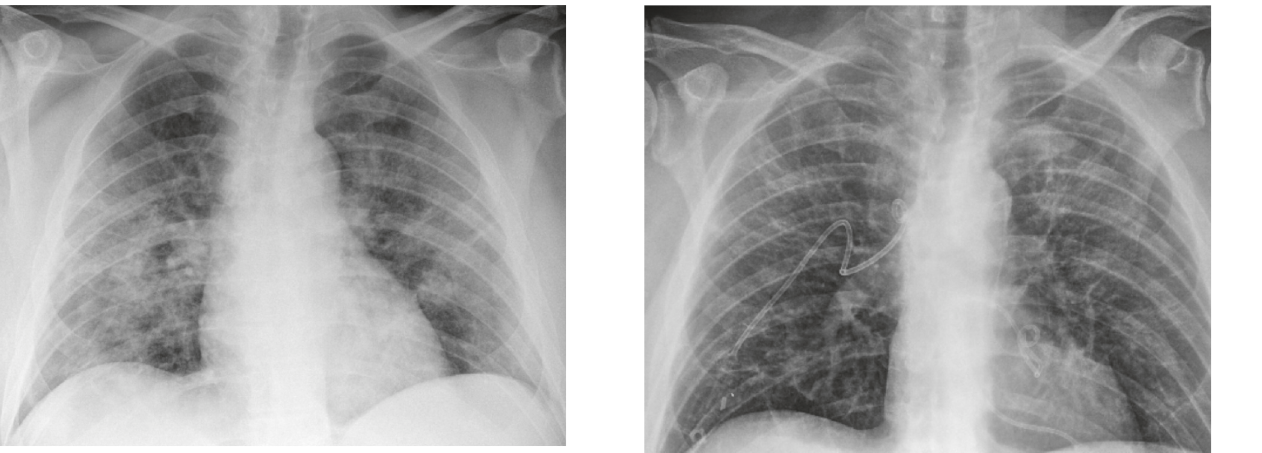
Figure 2: Anteroposterior chest radiographs of the patient during COVID-19 infection approximately 1 month prior to the current hospital admission.